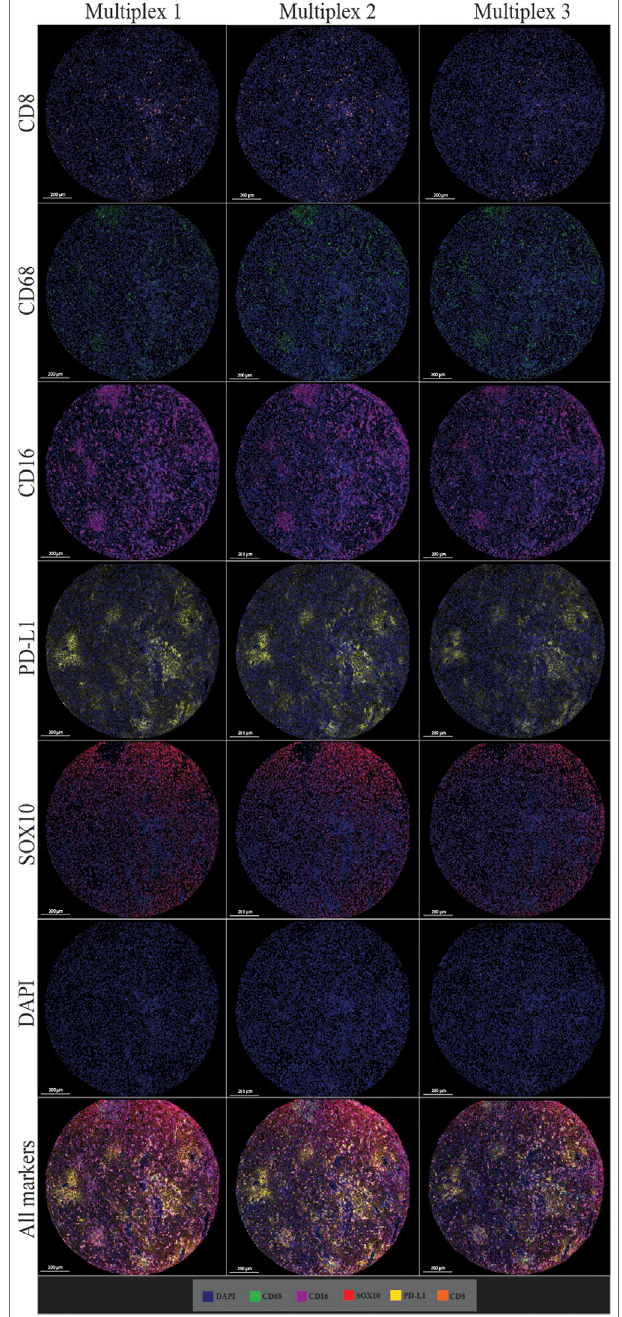
FIGURE 8 | Microphotographs of representative examples of staining in multiplex immuno fl uorescence cores from the same patient core for each marker show similar patterns of expression in each multiplex. Composite images show the integration of markers on a single slide. Scale bars are 200 μ m at ×7.5 magni fi